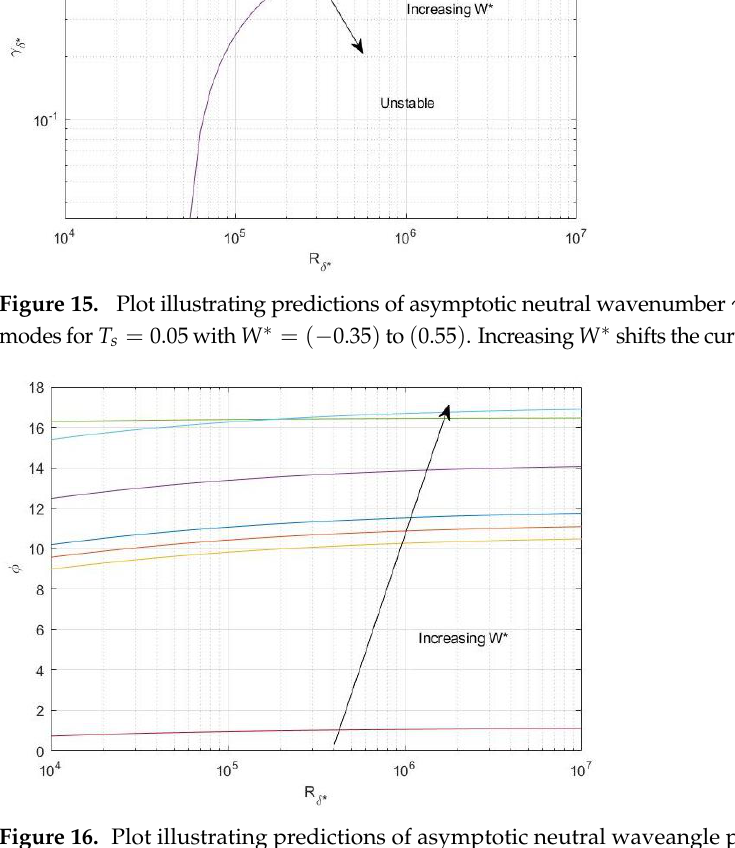
Figure 16. Plot illustrating predictions of asymptotic neutral waveangle predictions φ against R δ ∗ for type I modes for T s = 0.05 with W ∗ = ( − 0.35 ) to ( 0.55 ) . Increasing W ∗ shifts the curves vertically